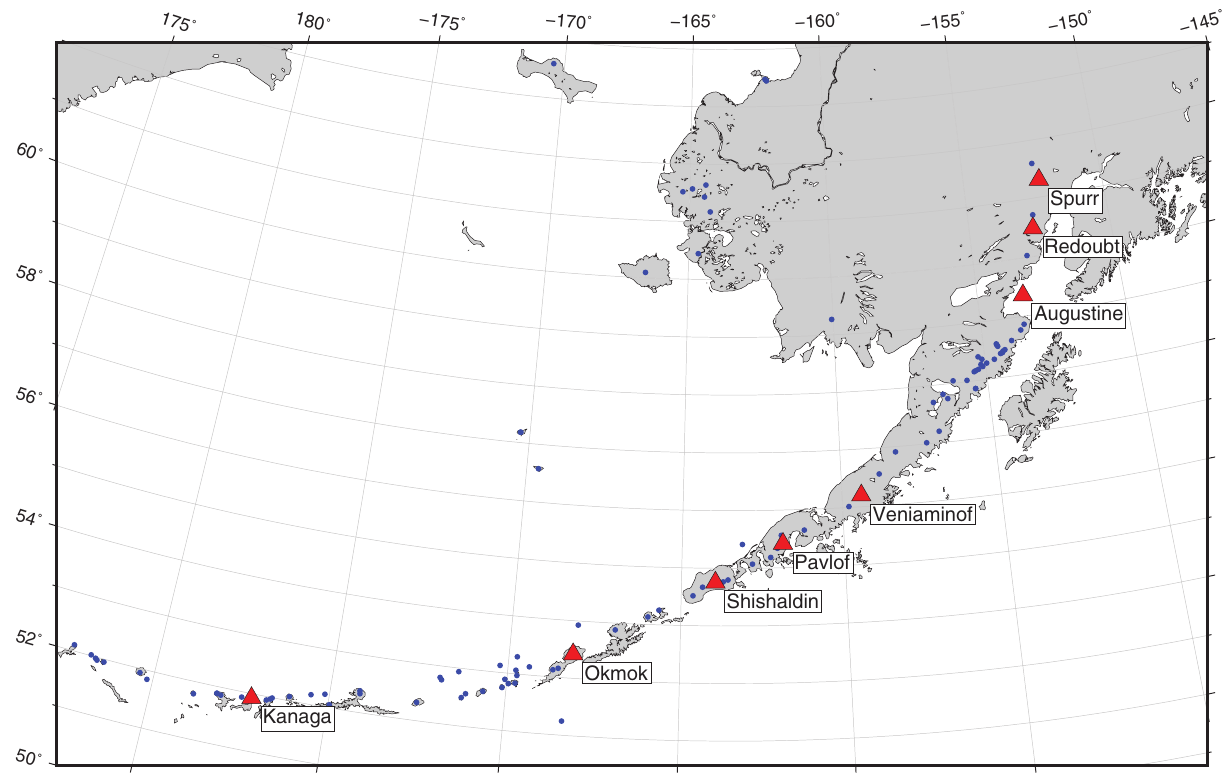
FIGURE 1 | Location of seismically monitored Alaskan volcanoes (red triangles) with eruptions analyzed in this study. Holocene eruptive centers are shown as blue